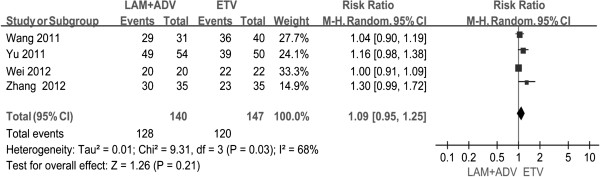
Effect of LAM + ADV vs. ETV at 48 weeks on biochemical response.